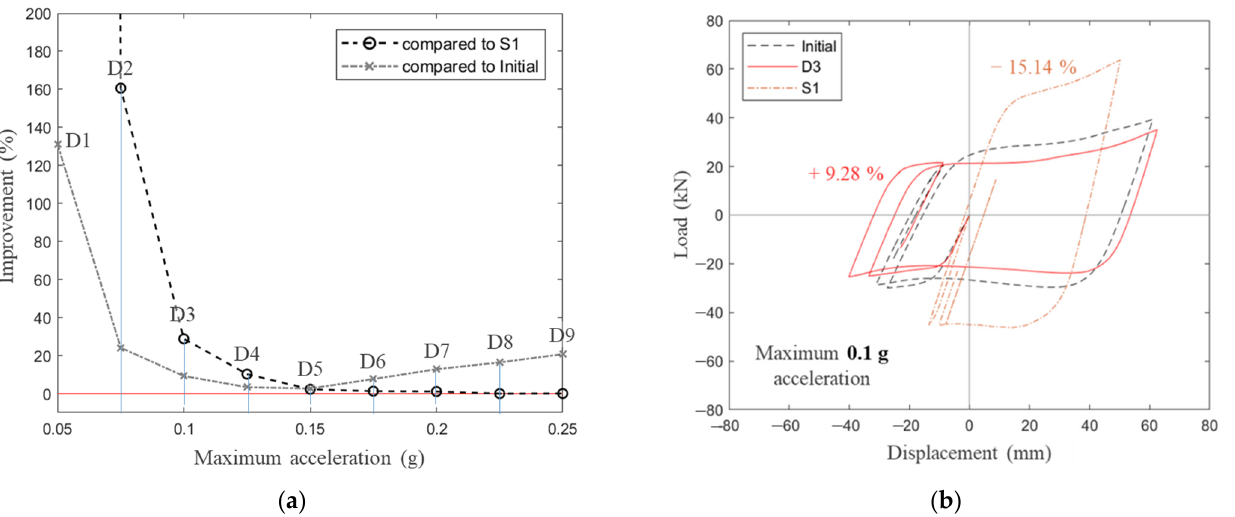
Figure 13. Dynamically optimized shapes under various acceleration conditions: ( a ) Representative stress distribution of the novel topology (Case D3); ( b ) Optimized results of all cases.